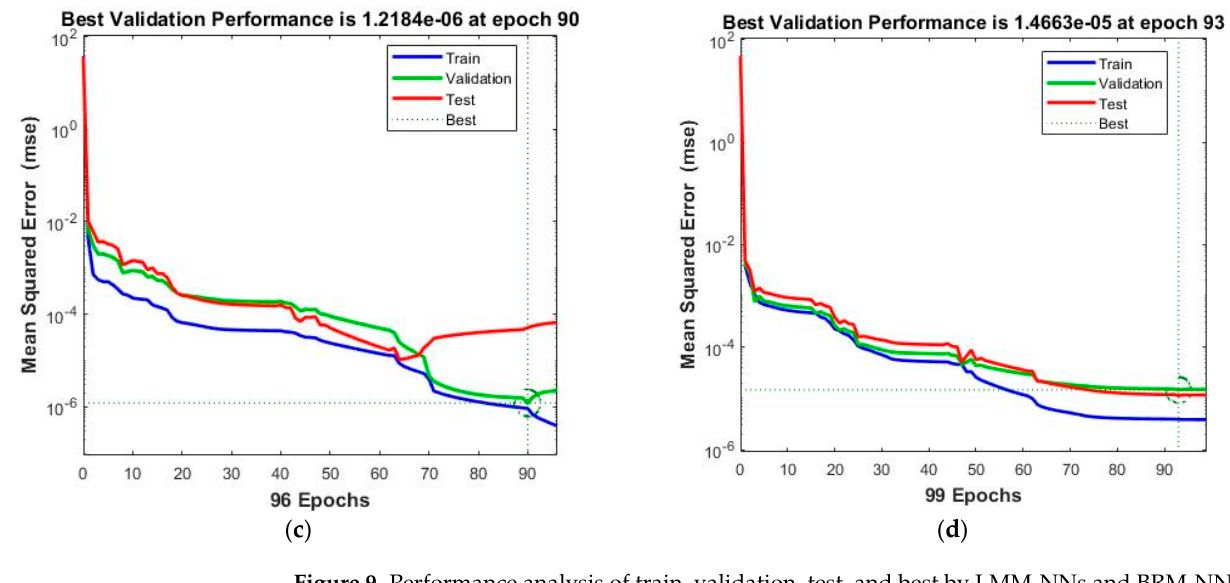
Figure 9. Performance analysis of train, validation, test, and best by LMM-NNs and BRM-NNs for all four cases of the Dahl-based hysteresis model. ( a ) LMM-NNs Case 1. ( b ) LMM-NNs Case 2. ( c ) LMM-NNs Case 3. ( d ) LMM-NNs Case 4.